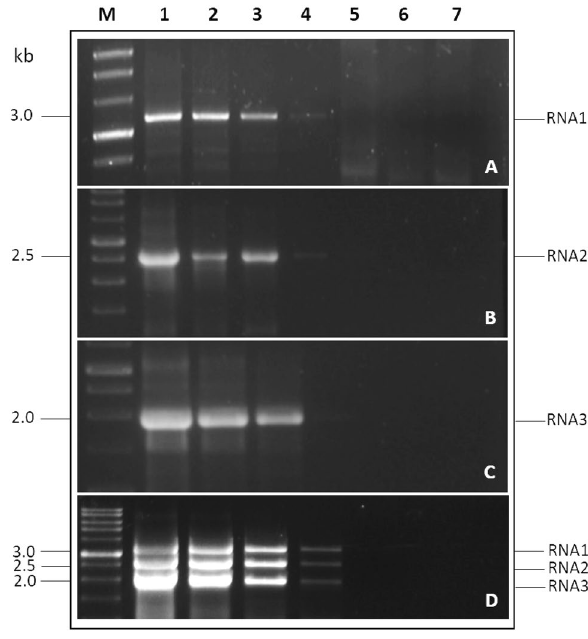
Figure 3. Sensitivity of two-step RT and mRT-PCR for all three fragments of PNRSV using tenfold serial dilutions of RNA. Lanes 1–6: 10 0 (400 ng)-10 –5 (0.004 ng) serial dilutions. Lane 7: water as a negative control. Lane M: 1 kb DNA ladder (RTU, GeneDireX,